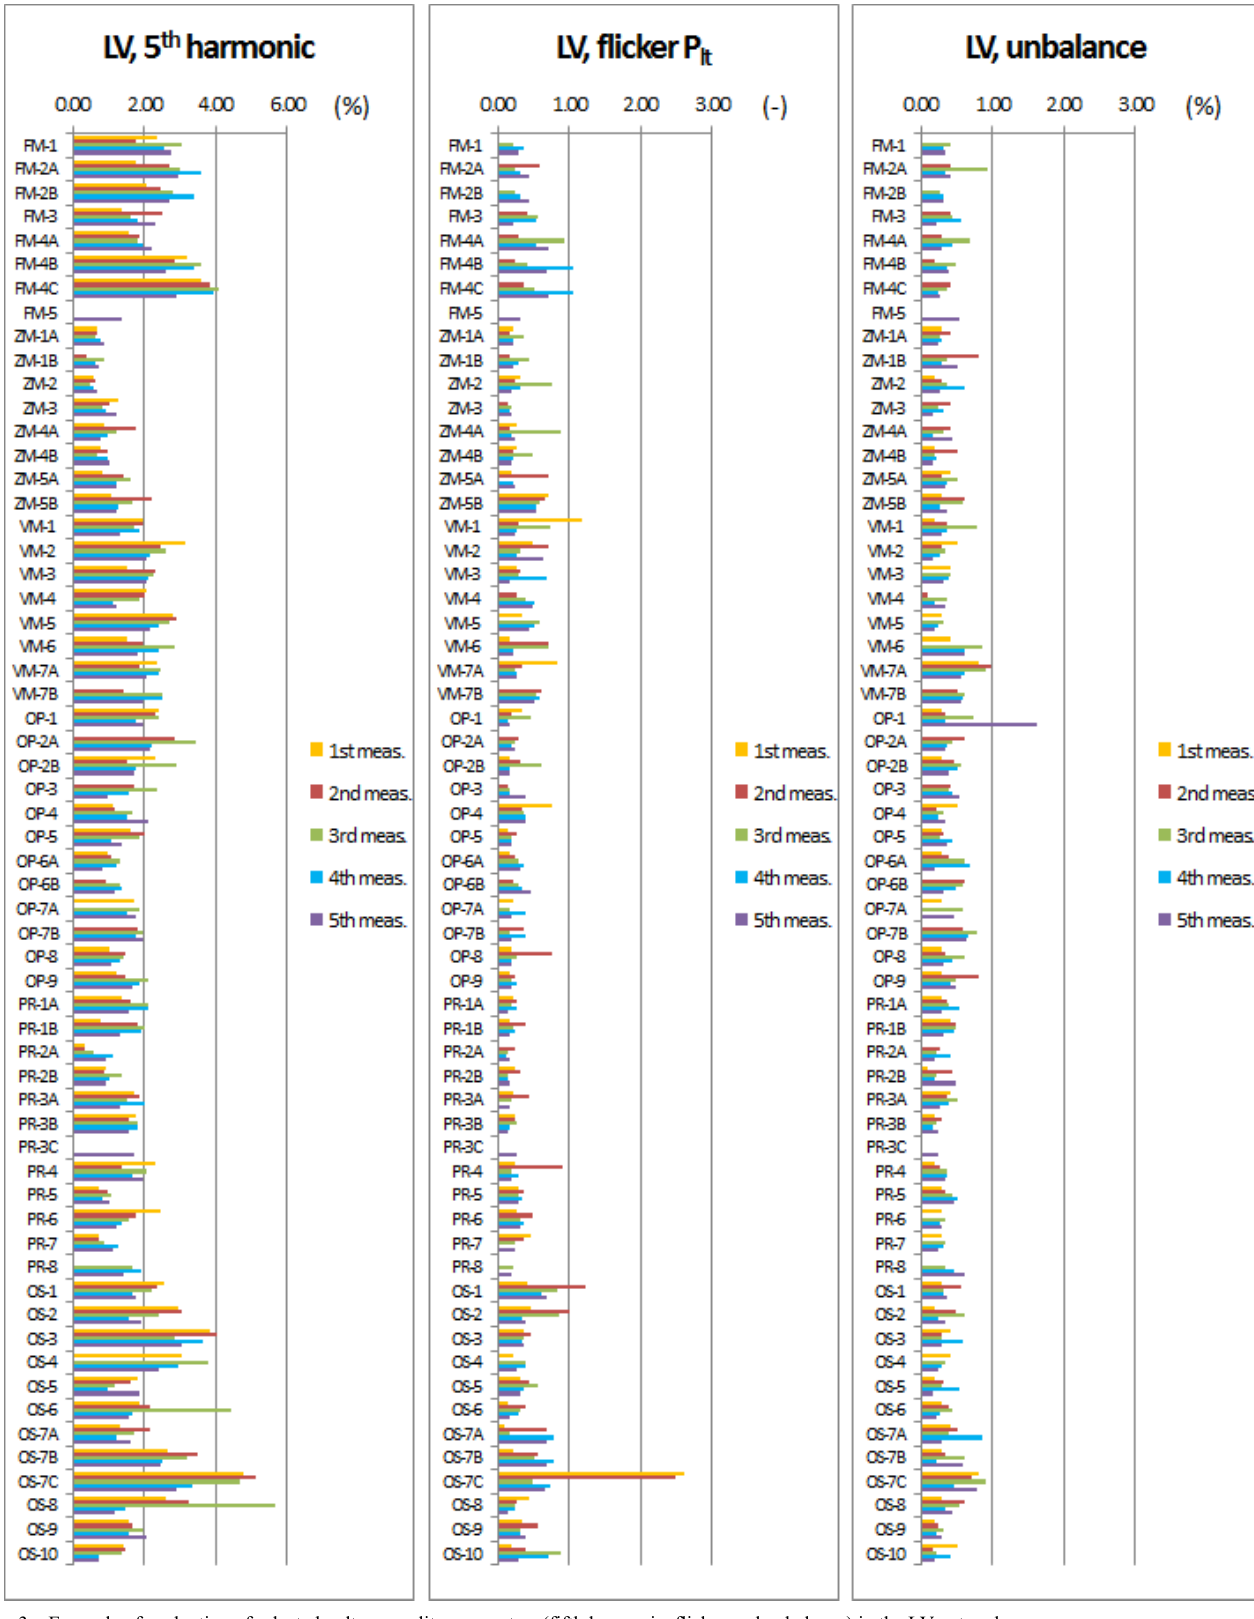
Fig. 3. Example of evaluation of selected voltage quality parameters (fifth harmonic, flicker and unbalance) in the LV